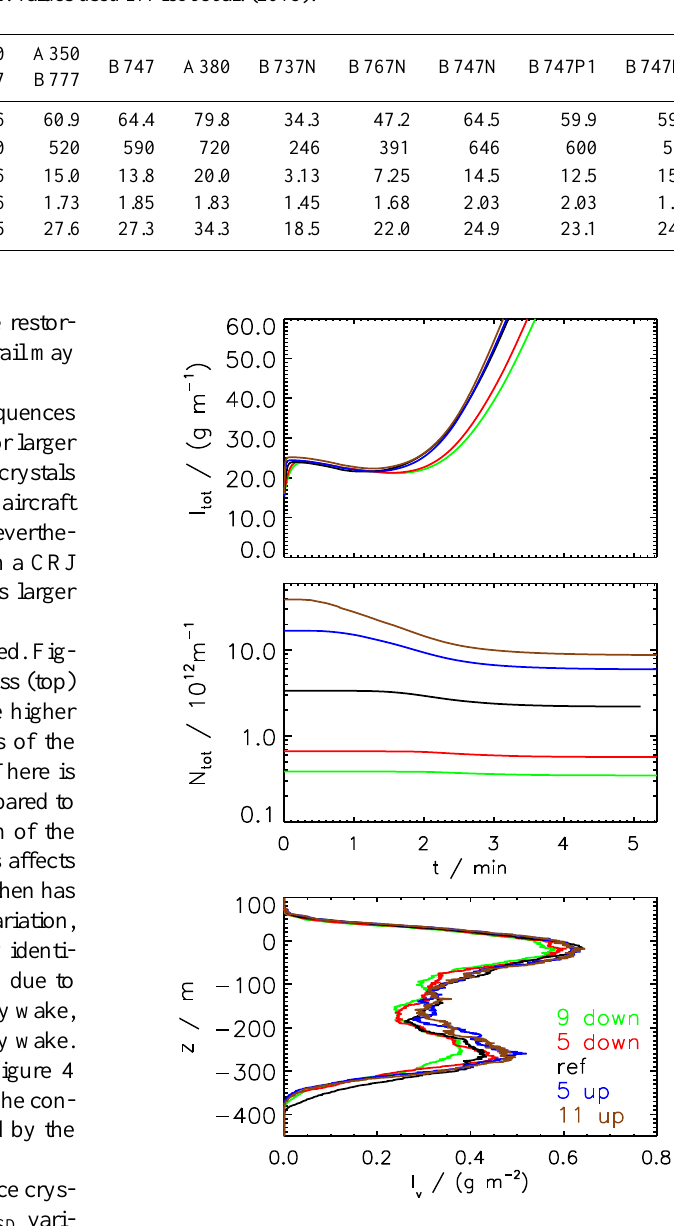
allows for the development of process-based parametrisa- tions for the survival fraction and the contrail depth. For the contrail-to-cirrus transition the ice crystal number matters, which is the product of initial ice crystal number and survival